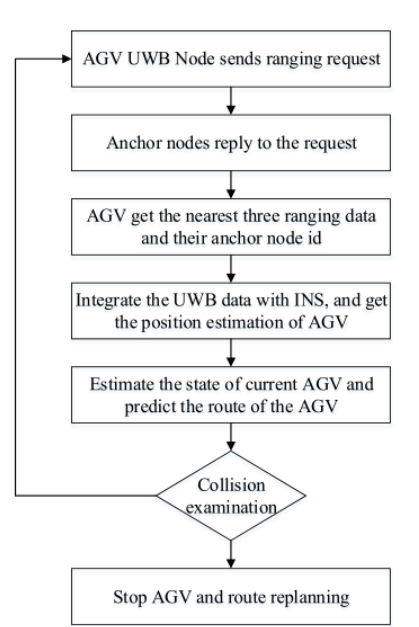
Figure 5. Flowchart of collision